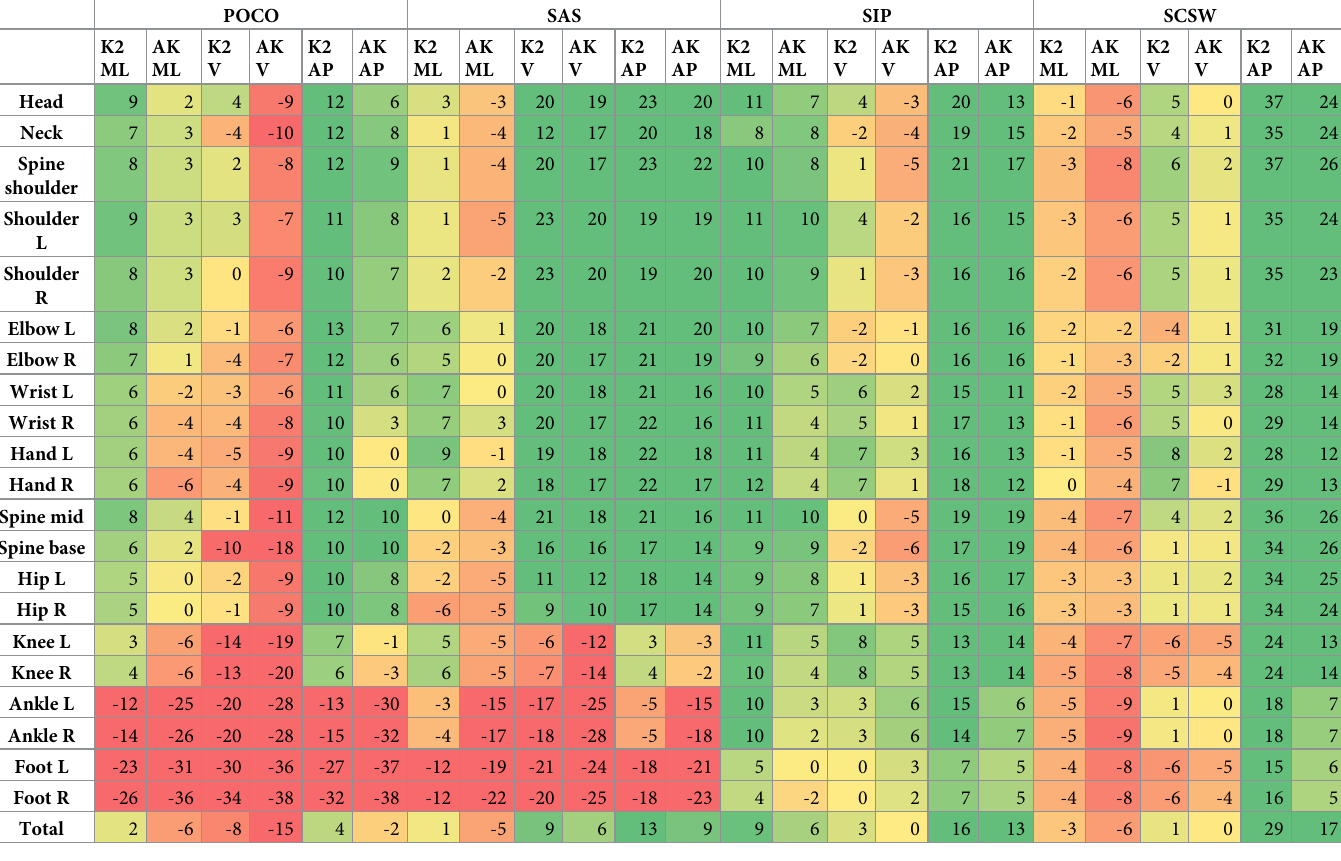
Table 4. Signal-to-noise ratios (SNR) of Qualisys marker movements and anatomical landmark movements from Kinect v2 and Azure Kinect where higher SNR indicate higher agreement between